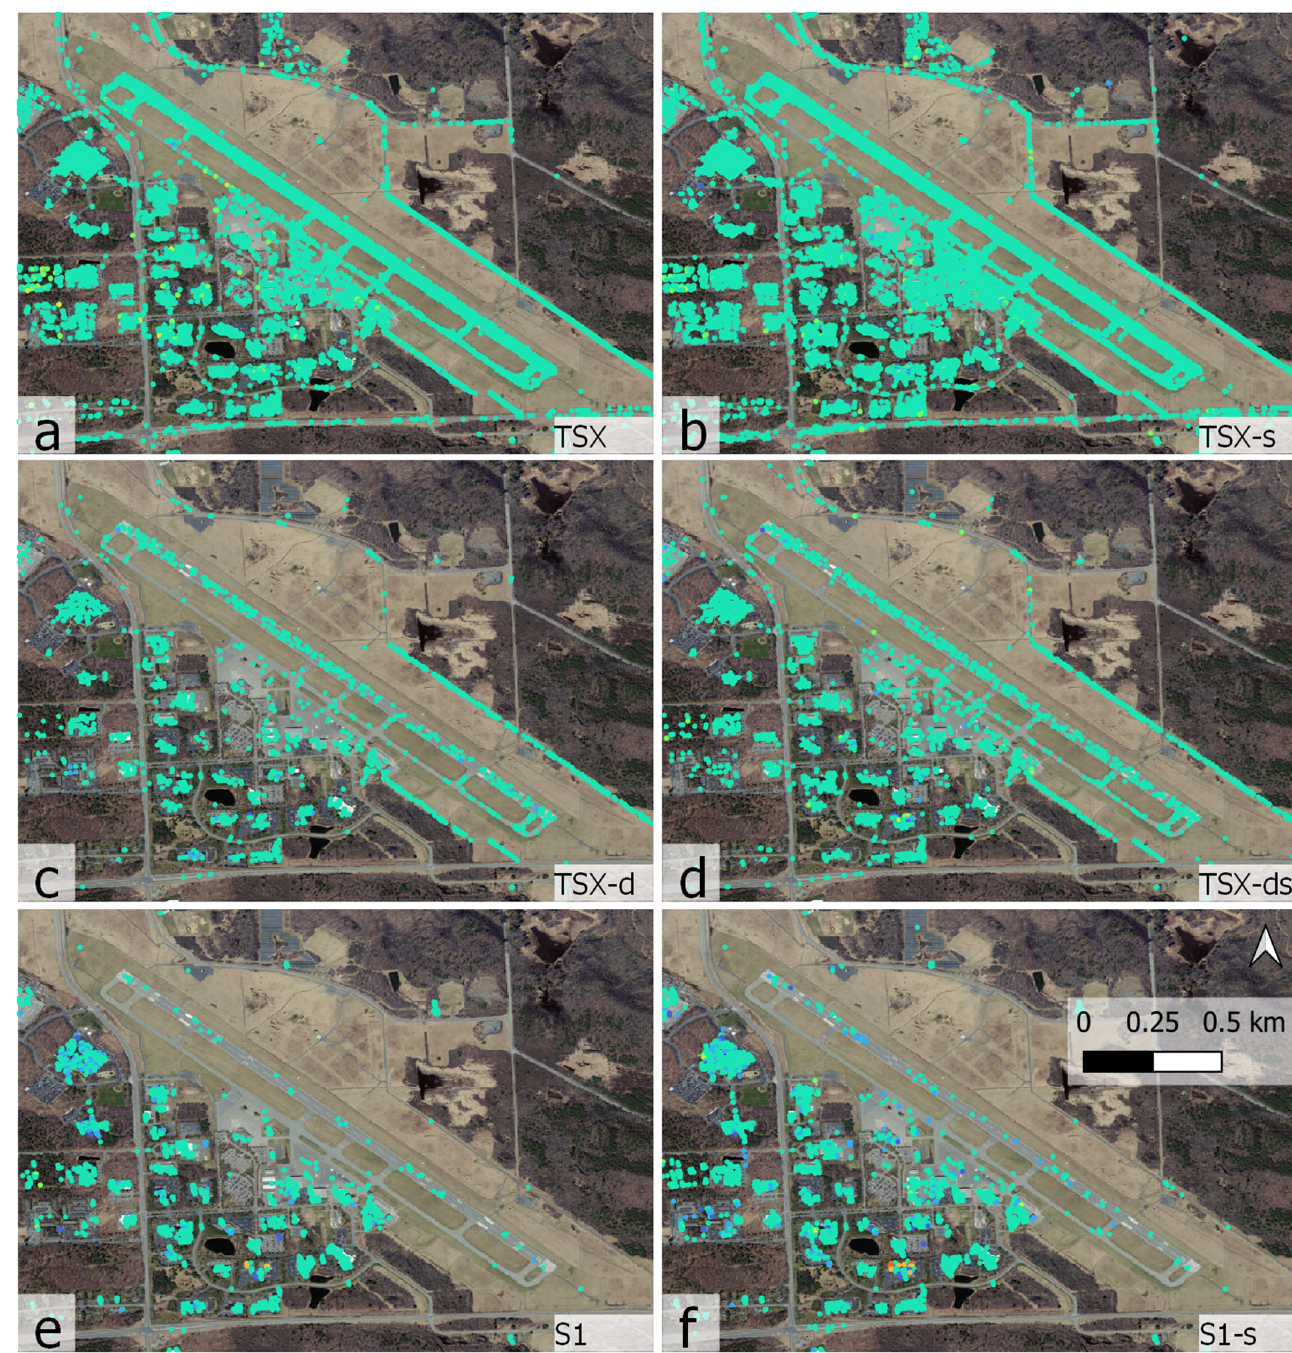
Figure 5. PS points over the Ithaca Airport. The number of PS points on and along the runway were 2421, 3297, 191, 279, 26, and 49 for TSX ( a ), TSX-s ( b ), TSX-dv ( c ), TSX-ds ( d ), S1 ( e ), and S1-s ( f ), respectively. The colormap is the same as in Figure 3. Basemap imagery available through Google: imagery CNES/Airbus, Maxar Technologies, New York GIS, USDA/FPAC/GEO; map data @2023.